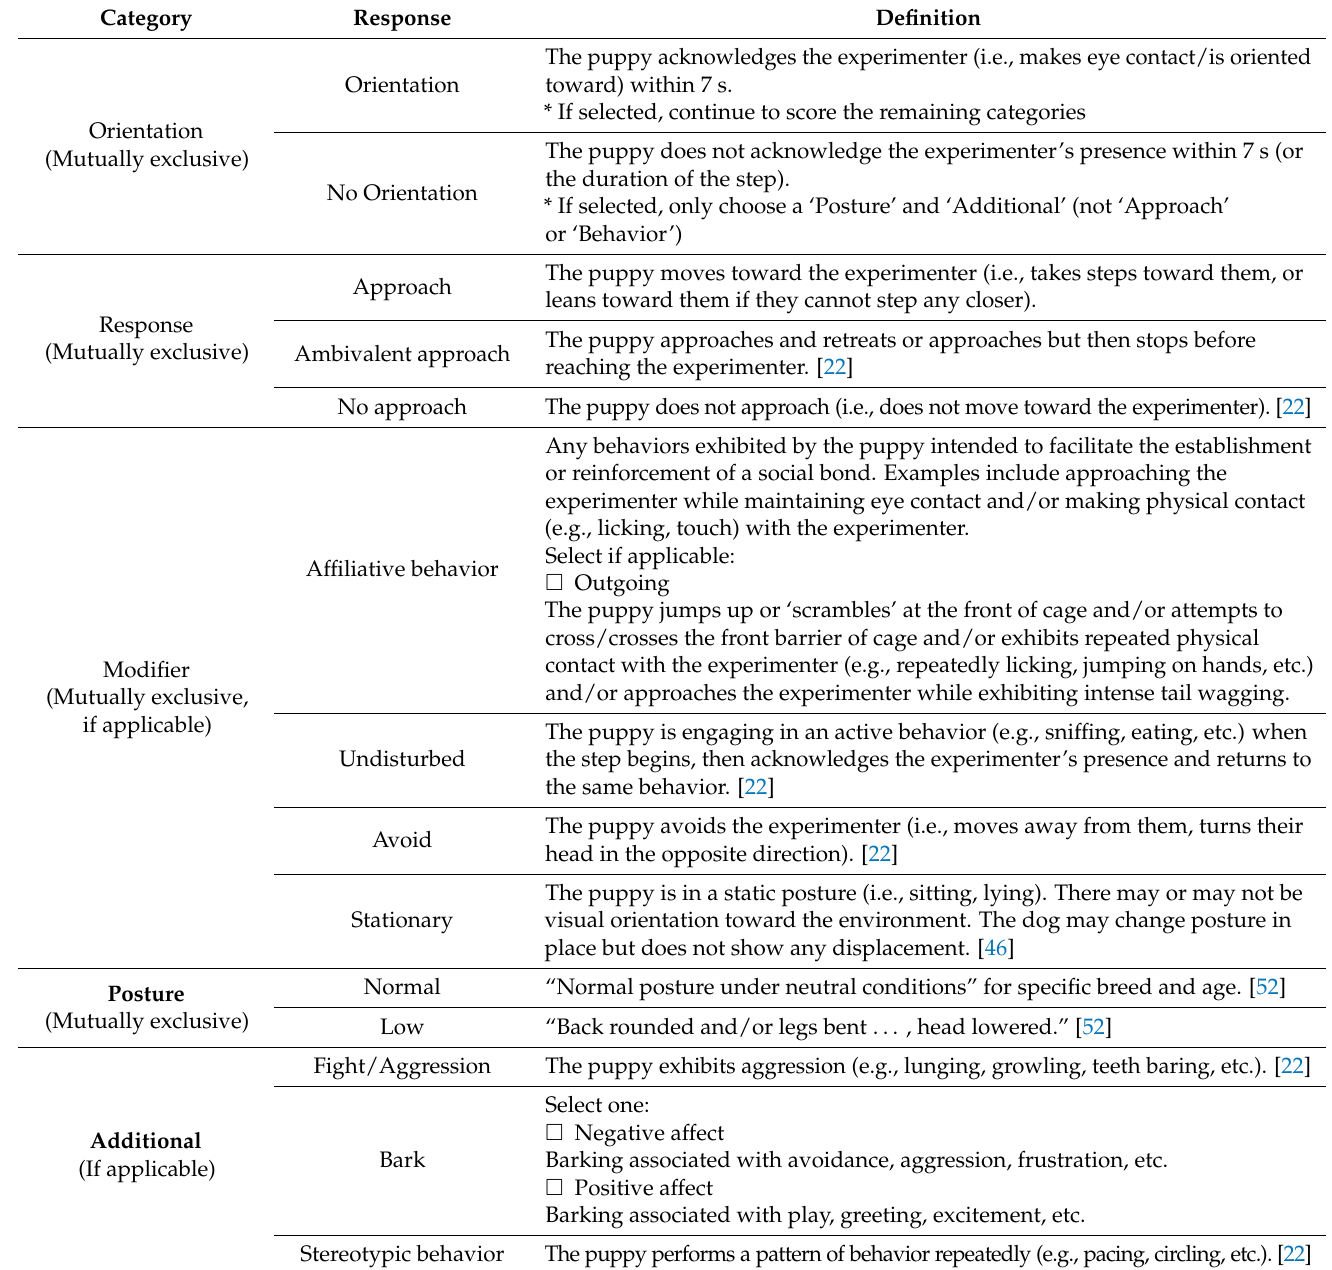
Table 2. Ethogram used to score puppies’ behavioral responses to each step of the